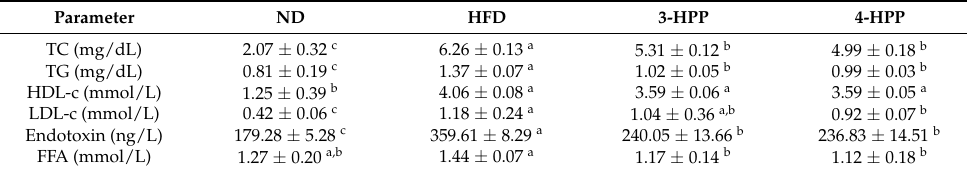
Table 2. The influence of 3 − HPP and 4 − HPP on serum biochemical levels.